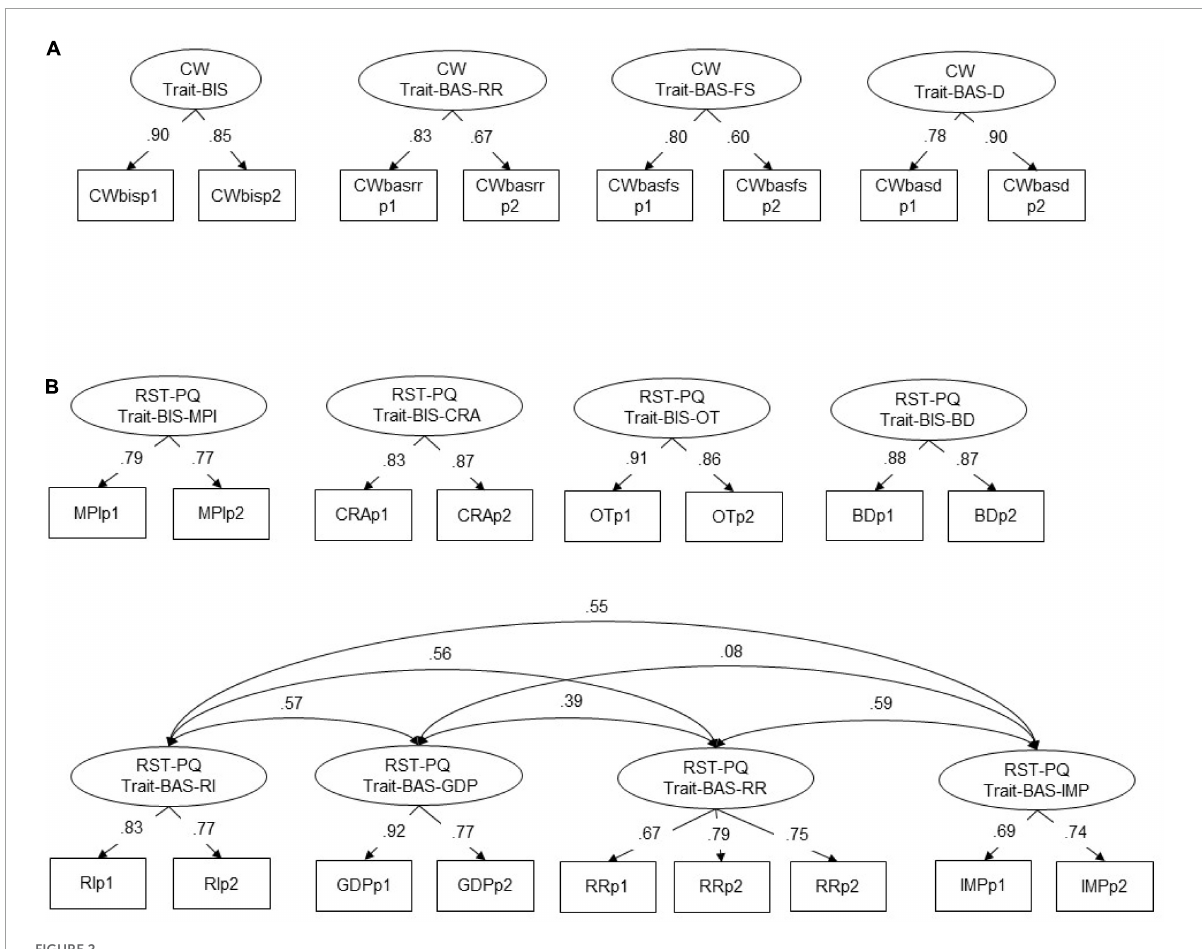
FIGURE2 Standardized factor loadings (STDYX) of four-factor models for the Carver-White BIS/BAS questionnaire including one BIS and three BAS subfactors (A) and for the RST_PQ including four BIS and four BAS subfactors (B) . BD, behavioral disengagement; CRA, cautious risk assessment; D, drive; GDP, goal-drive persistence; FS, fun seeking; IMP, impulsivity; MPI, motor planning interruption; OT, obsessive thoughts; RI, reward interest; RR, reward reactivity; CW-trait-BAS-RR, reward responsiveness. All p -values p < 0.01,